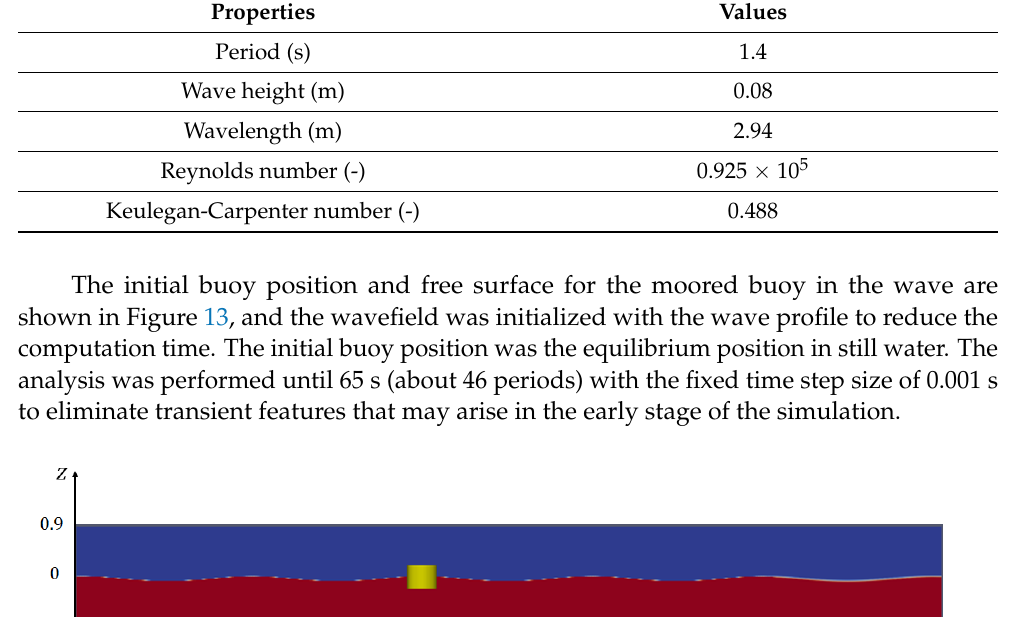
Figure 13. Initial buoy position and free surface for a moored buoy in wave.